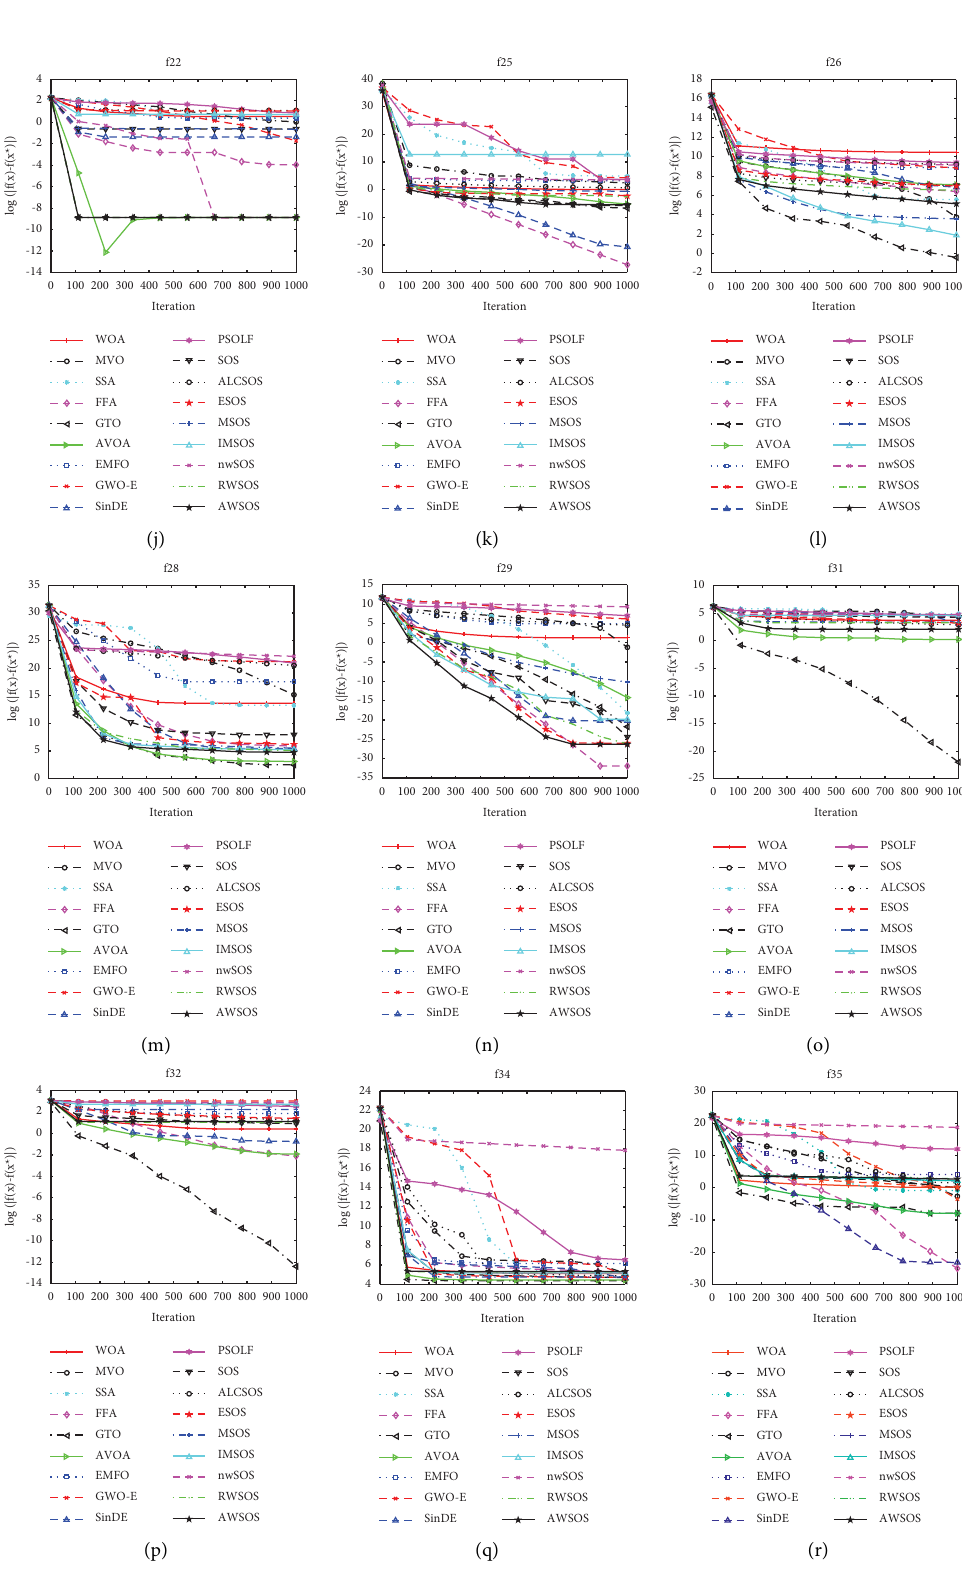
Figure 2: Comparison of performances of algorithms for benchmark